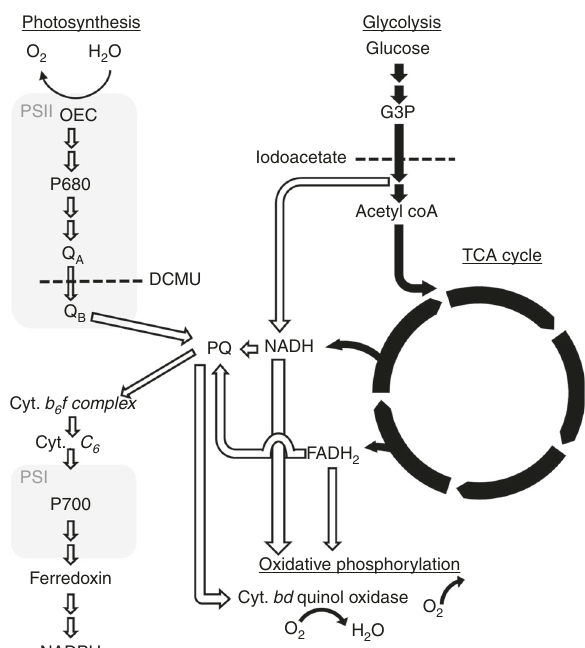
Fig. 1 The electron fl ow of the photosynthetic process and respiration metabolism in cyanobacteria. The scheme was drawn based on the data described in references 12 – 21. Filled black arrows mark the respiration metabolism. Un fi lled arrows indicate the photosynthetic and additional electron fl ow processes. Double arrows mark additional steps not shown for clarity. G3P is glyceraldehyde 3 phosphate, and TCA stands for tricarboxylic acid cycle. The membrane soluble plastoquinone (PQ) functions as an acceptor of residual electrons of the glycolysis and the TCA cycle, as well as an essential mediator of the photosynthetic electrons between PSII and the b 6 f complex. Dashed lines indicate the site of action of inhibitors of the photosynthetic or respiratory, used in this